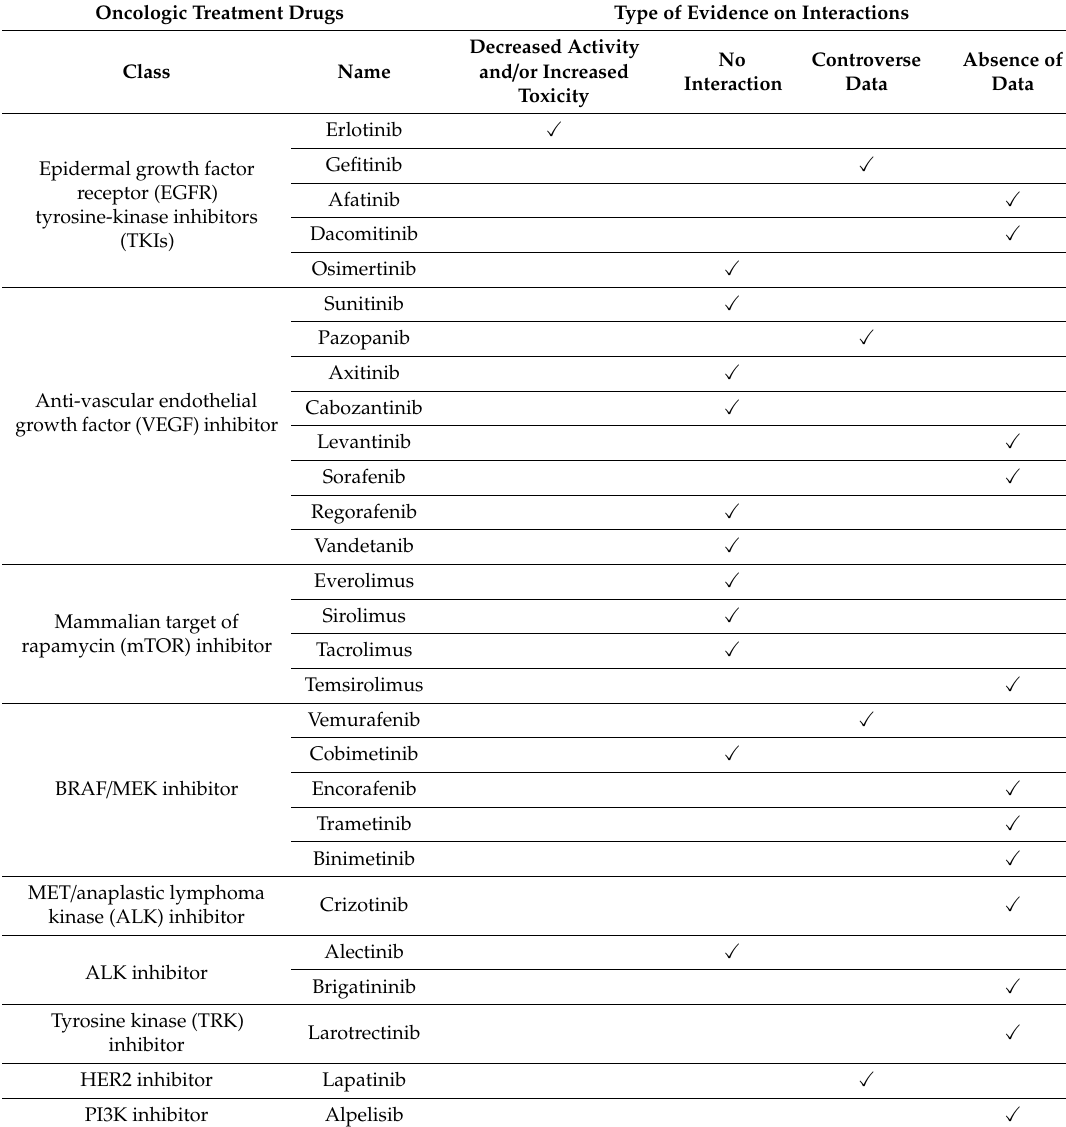
Table 1. Interactions between Oncologic Drugs and Proton Pump Inhibitors. Oncologic Treatment Drugs Type of Evidence on